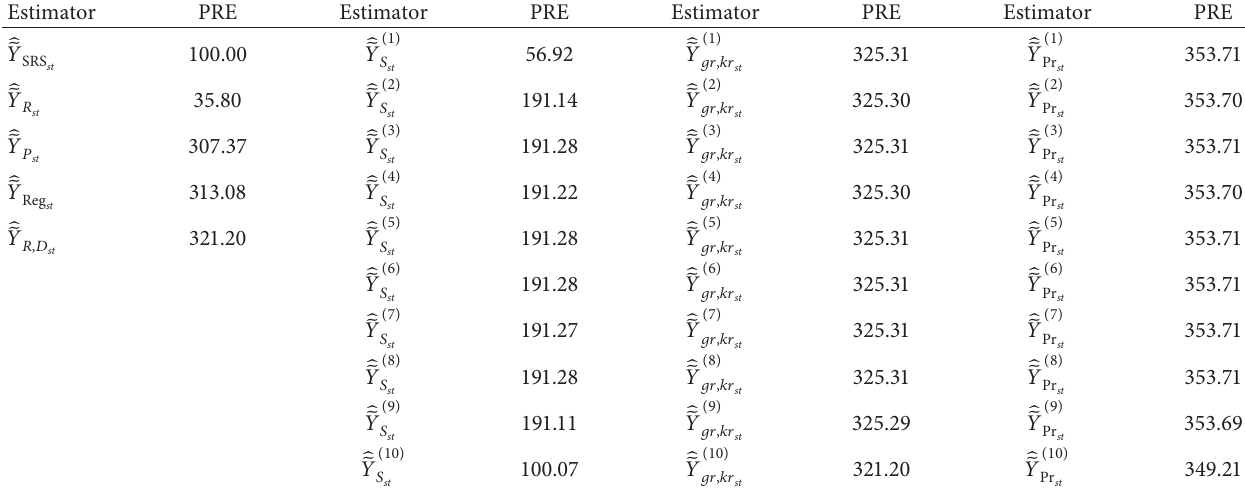
Table 13: PREs of finite population mean estimators using population 2 (scenario I).